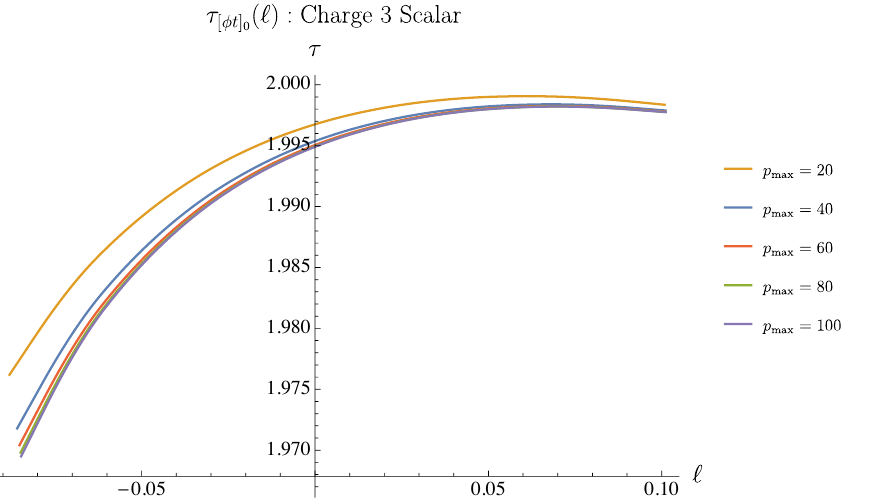
Figure 15 . The analytic prediction for the twist of the [ (cid:30)t ] 3 various orders in dimensional reduction for isolated operators in the inversion